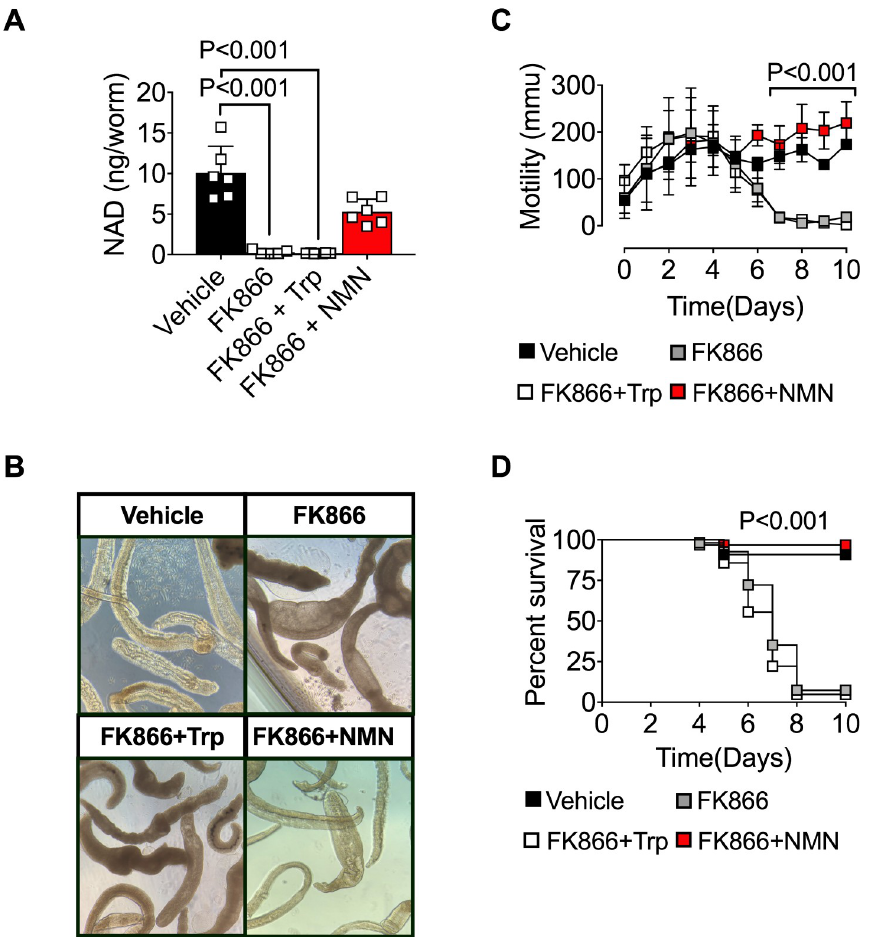
Fig 4. The NAD salvage pathway controls metabolism and survival of immature S . mansoni . (A) Intracellular NAD levels in S . mansoni schistosomula cultured for 48h with vehicle or 250nM FK866 ± 2mM NMN or Trp. n = 6 wells/ group with 2 schistosomula/well. (B) Representative light microscopy images of schistosomula 7 days post-treatment with vehicle or 250nM FK866 ± 2mM NMN or Trp. (C) Parasite mobility by S . mansoni schistosomula cultured for 10 days with vehicle or 250nM FK866 ± 2mM NMN or Trp. n = 3 wells/group with 45–60 schistosomula/well. (D) Survival of schistosomula cultured for 10 days with vehicle or 250nM FK866 ± 2mM NMN or Trp. Data are shown as the percentage of parasites alive at each timepoint. n = 45–60 parasites/group. Data are representative of 2 independent experiments. Data shown as the mean ± SD with individual samples in squares (A, C). Statistical tests were performed using one-way ANOVA multiple comparison tests or Log-rank (Mantel-Cox) test for